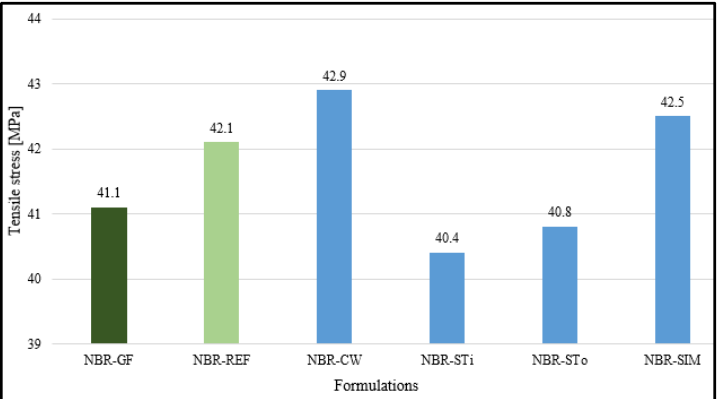
Figure 4. Tensile stress at first break of the epoxy coatings with different fillers.